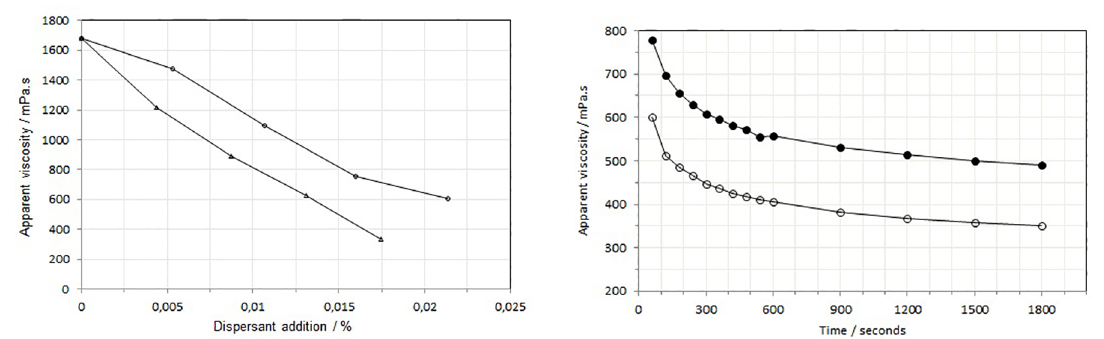
Figure 4. Apparent viscosity variation as a function of time to an alumina-suspension (closed circles) and HA-suspension (open circles) with 0.016 wt% of HA. Constant shear rate of 75 s -1 to a suspension after 48 hours of rest. pH